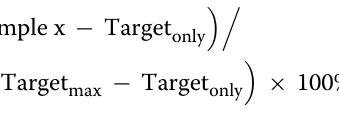
Additional file 1: Figure S1. Characterization of Nanotrapped